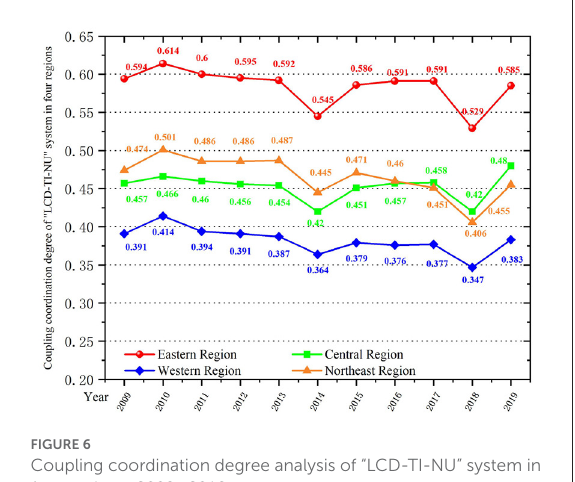
FIGURE6 Coupling coordination degree analysis of “LCD-TI-NU” system in four regions,